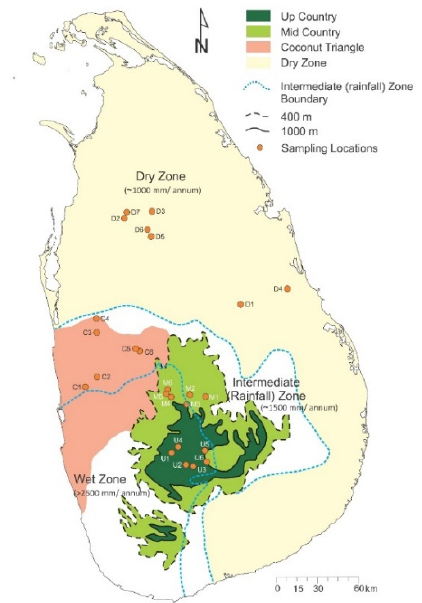
Figure 1. Milk sampling locations and agroclimatic zones of Sri Lanka.